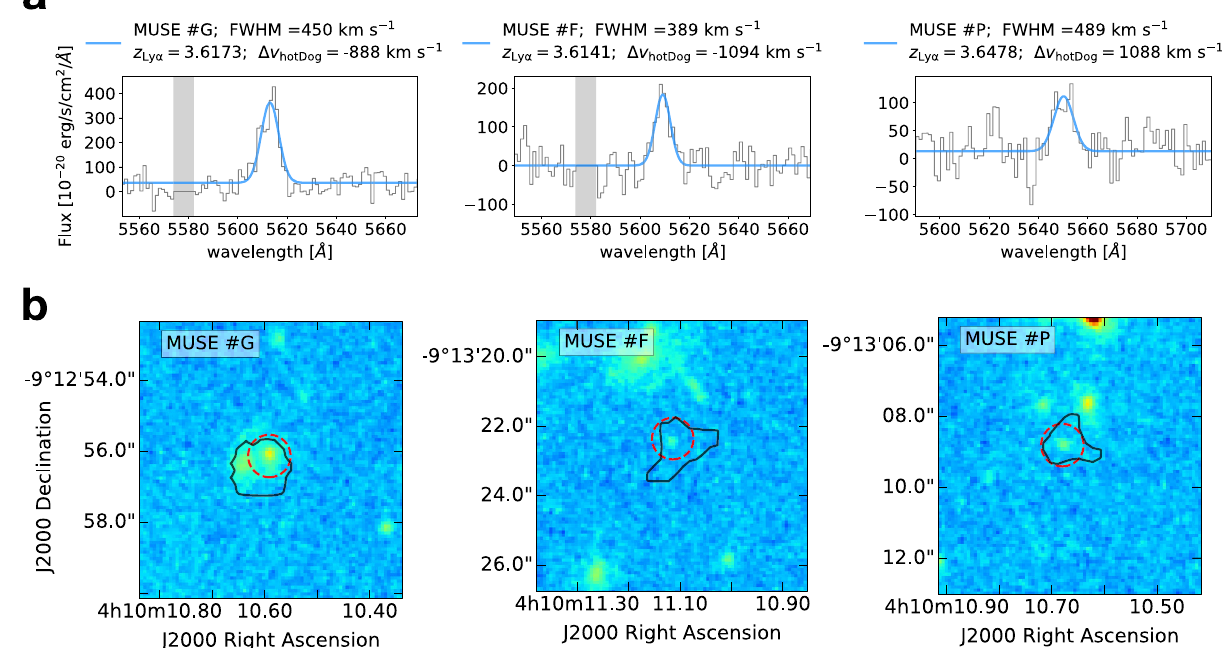
Fig. 7 | MUSE spectra and HST maps for a selection of companion galaxies around W0410-0913. a Lyman- α spectra of 3 among the Lyman- α -emitters dis- coveredwithMUSEinthesurroundingenvironmentofW0410-0913.Theseobjects belong to the denser dynamic volume (with offset velocities in the range [ − 2.500; +1.500]kms − 1 ), have HST detections, and are selected to be representative of the high (left), median (center), and low (right) distribution of the Lyman- α fl ux SNR (see Table 1). Lyman- α spectra, extracted from circular regions with a radius of 1 ″ and centered around the Lyman- α peaks, are shown in gray. The wavelength range in the x-axis has a width of 120 Å and is centered around the central wavelength obtained through a Gaussian fi t (Gaussian models are shown in blue). Legends